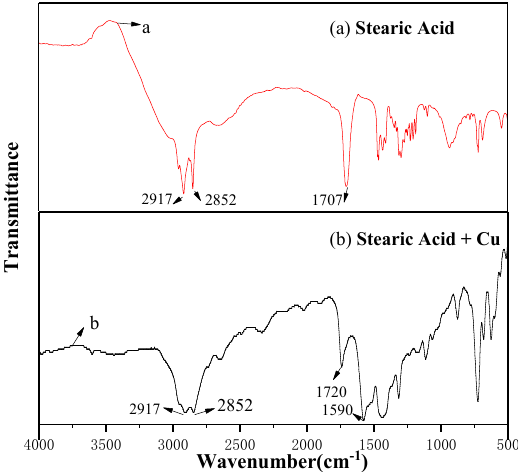
Figure 5. Fourier transform infrared spectroscopy (FT-IR) spectra: ( a ) stearic acid; ( b ) stearic acid + Cu.